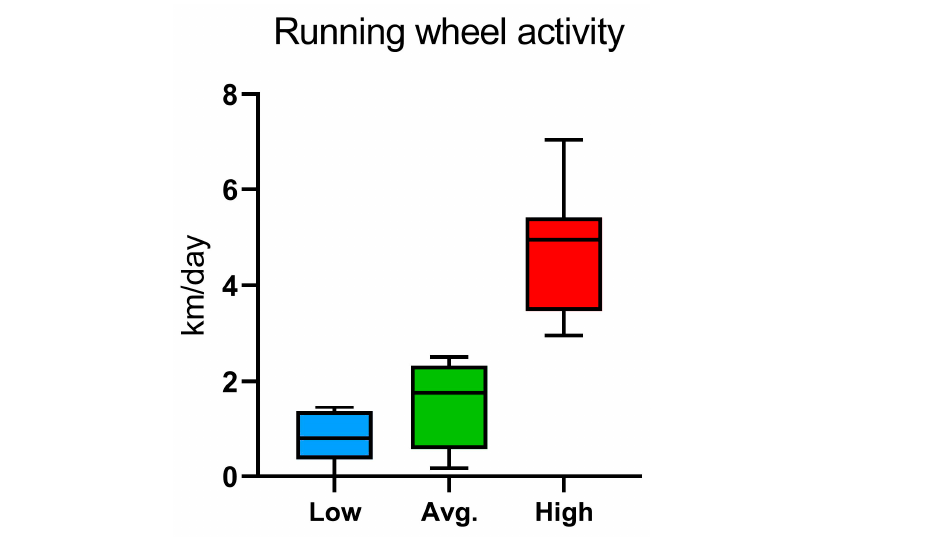
Figure 1. Study groups assigned according to the running wheel activity in PhenoMaster, categorized as kilometers (km) per day into low runners (Low; n = 7), average runners (Avg.; n = 8), and high runners (High; n = 7). Data are presented as mean and standard deviation.